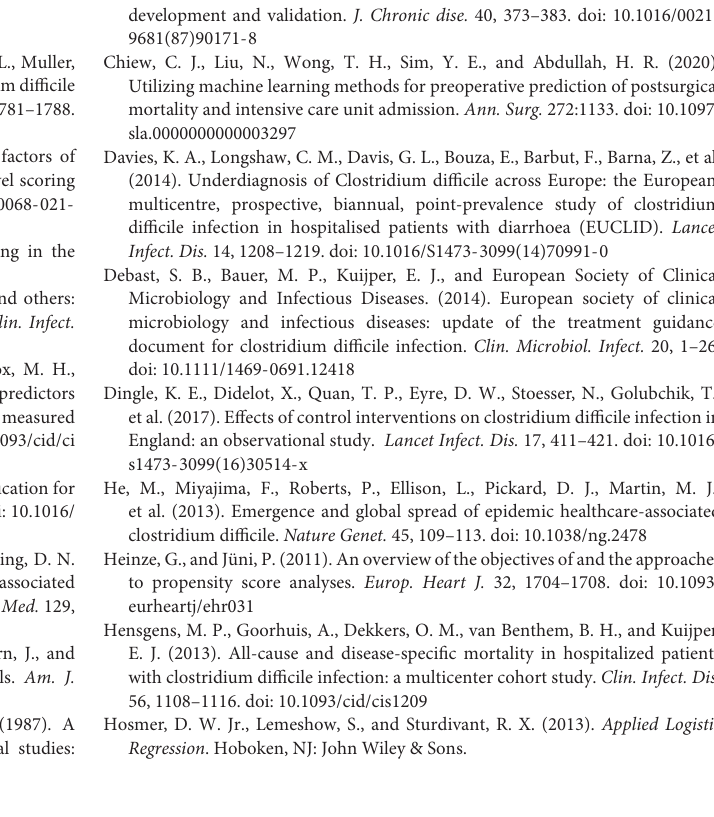
Supplementary Figure 1 | Described progression-free survival curves for three types of SOFA SCORES [including changes in SOFA score (A) , quick SOFA (B) , and SOFA (C) ]. Supplementary Figure 2 | Critical variables with important plot for predicting severe CDI. Feature importance including feature weight, mean gain, and coverage of eXtreme gradient